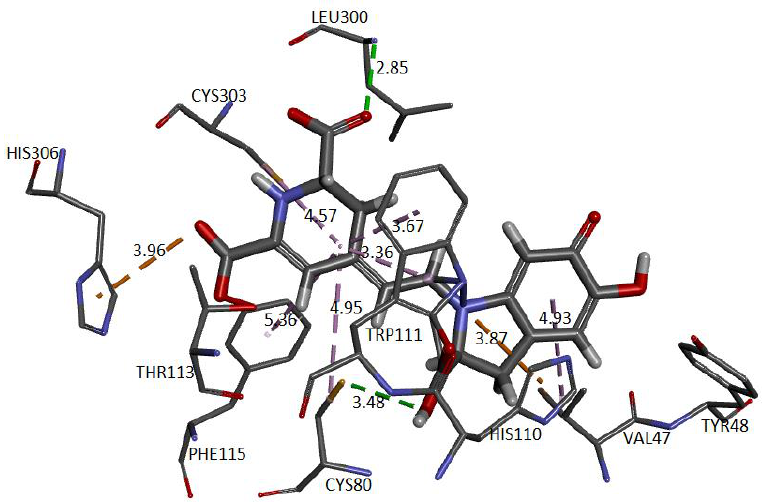
Figure 25. Molecular basis of potential active site interactions with deprotonated Bd (C6C15C17- COOH) via our method founded on shape theory.